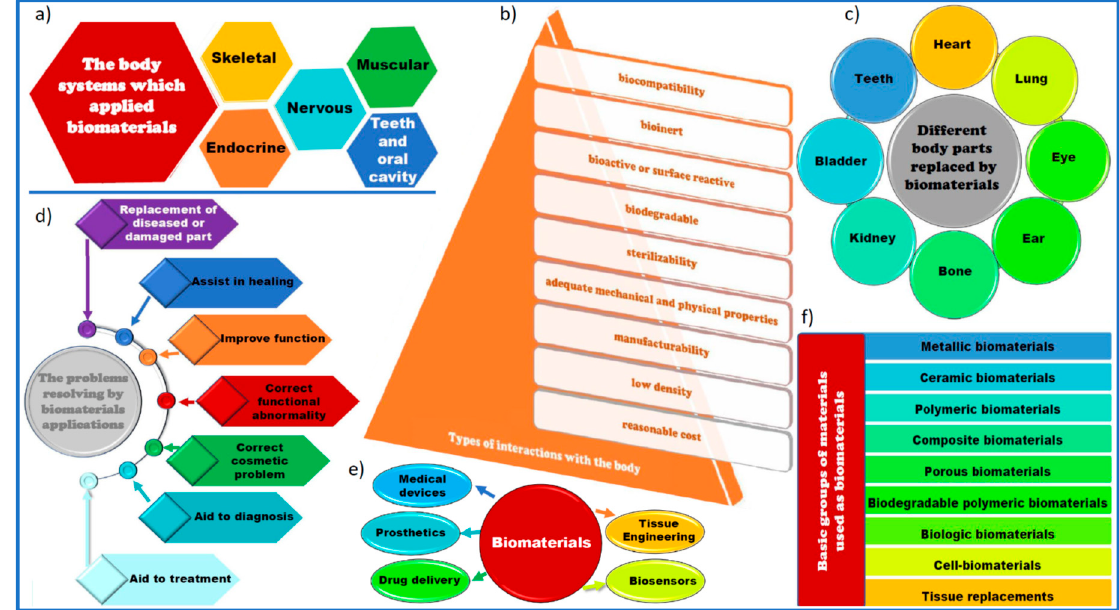
Figure 23. The general classification of biomedical materials according to various criteria: ( a ) the body systems which applied biomaterials; ( b ) types the interactions with the body; ( c ) different body parts replaced by biomaterials; ( d ) the problems resolving by biomaterials application; ( e ) applications areas of biomaterials; ( f ) basic groups of materials used as biomaterials.